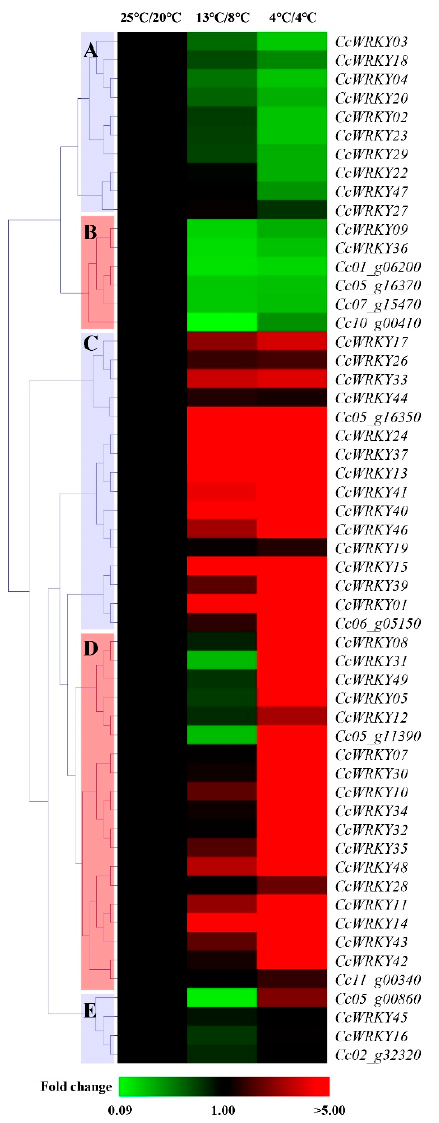
Figure 4. qRT-PCR analysis of expression patterns of CcWRKYs and their ten putative targeted genes under cold stress. A , genes were downregulated by 4 ◦ C / 4 ◦ C cold treatments. B , genes downregulated by 13 ◦ C / 8 ◦ C and 4 ◦ C / 4 ◦ C cold treatments. C , genes were upregulated by 13 ◦ C / 8 ◦ C and 4 ◦ C / 4 ◦ C cold treatments. D , genes were upregulated by 4 ◦ C / 4 ◦ C cold treatments. E , genes with no significantly changed expression under cold treatment. Table 2. GO enrichment of the 235 putative CcWRKY target genes involved in the biological processes of response to cold (GO: